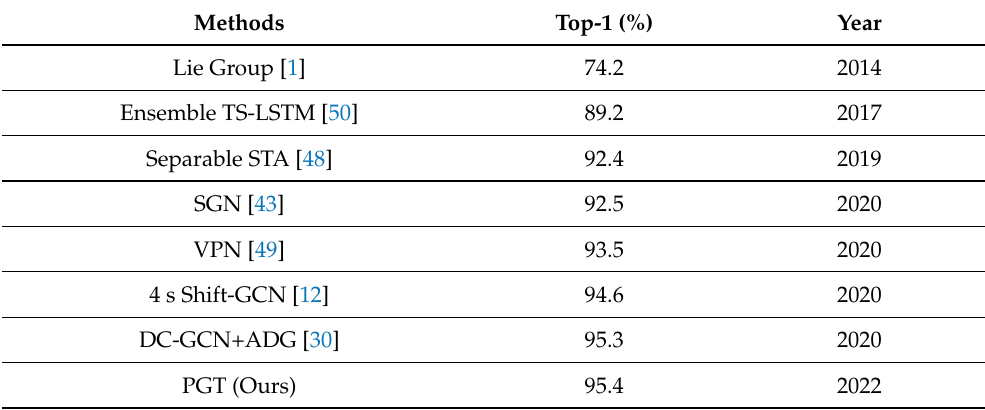
Table 7. Comparisons of the experiment results on the Northwestern-UCLA dataset.